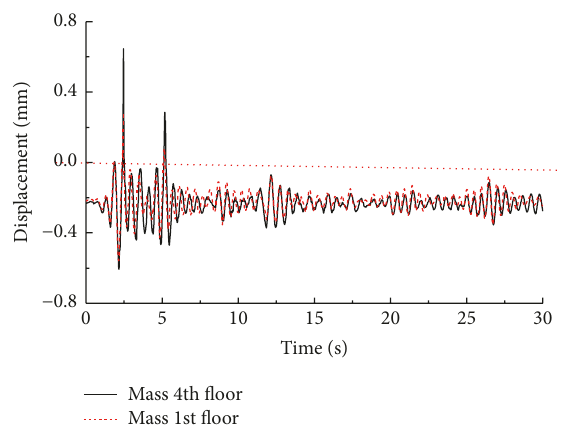
Figure 34: Vertical displacement time history curves at node 1 on the structure base mat under two cases: concentrated mass located on the fourth and first floor.